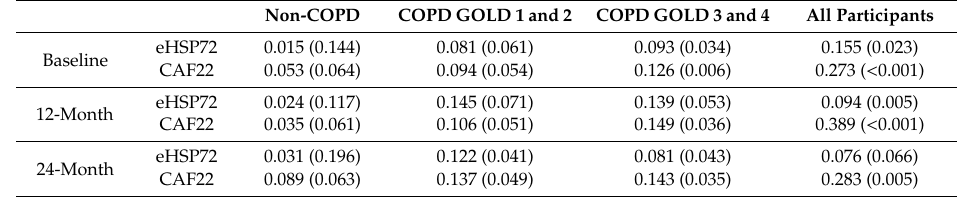
Table 2. Correlations coefficients of plasma biomarkers with FEV 1 % at various time points ( N = 64–68 / group / time point). The numbers in parenthesis indicate p -values. Non-COPD COPD GOLD 1 and 2 COPD GOLD 3 and 4 All